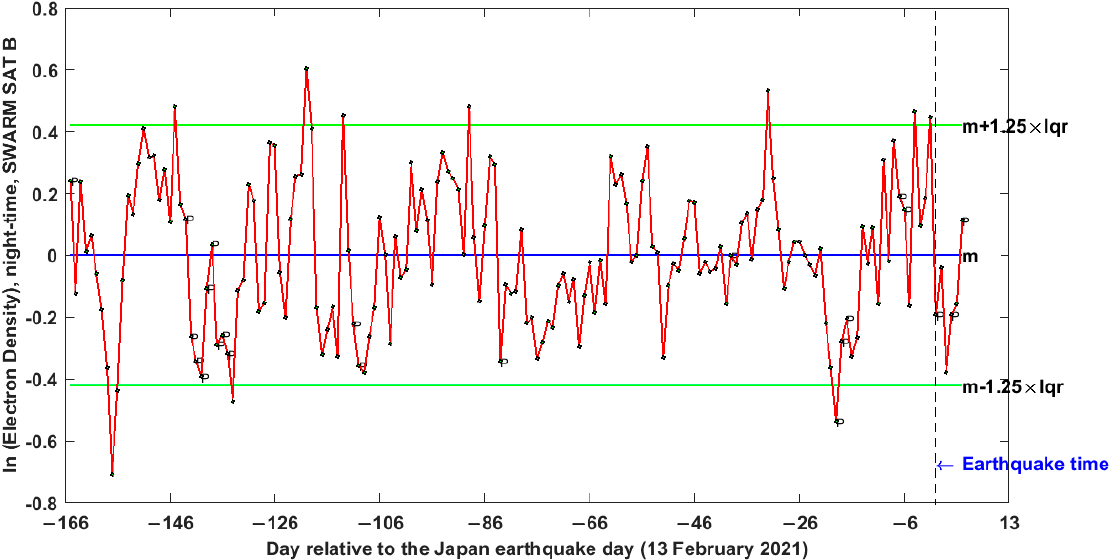
Figure 4. Results of Swarm B electron density data analysis for the Japan earthquake (13 February 2021) from 1 September 2020 to 18 February 2021 at night-time. The natural logarithm and 7-degree polynomial detrend have been applied to the time series. Blue and green lines represent the median value and the selected thresholds to detect the anomalies. If a day experiences some geomagnetic perturbation, it is depicted with the letter “P” on the graph.